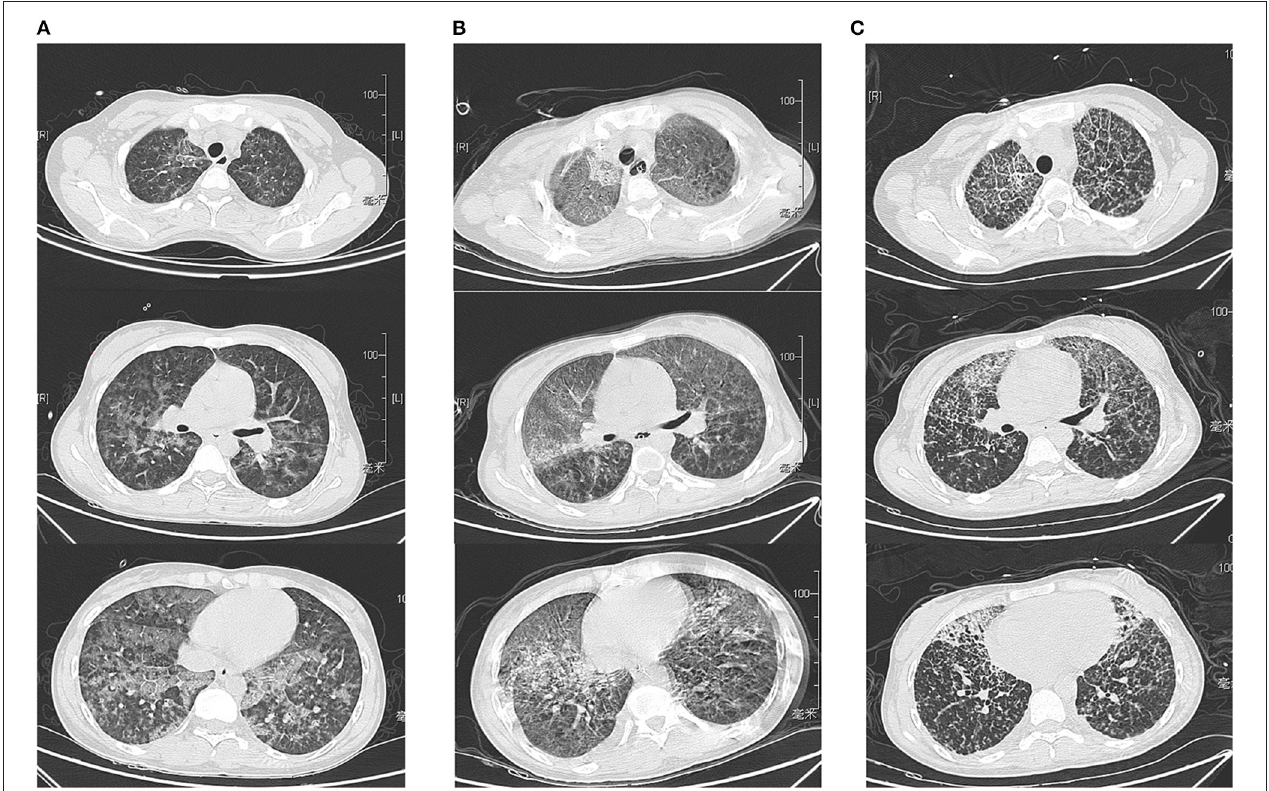
FIGURE 1 | Chest CT results on day 1, day 7, and day 14 after admission. (A) Chest CT findings on the first day of admission revealed diffuse pneumonitis throughout the lungs. (B) The patient’s chest CT on day 7 showed a worsening of the infection (due to the severity of the disease, the patient could not hold her breath well, so the images were not clear). (C) On the 14th day of admission, the patient’s chest CT results showed slight improvement after